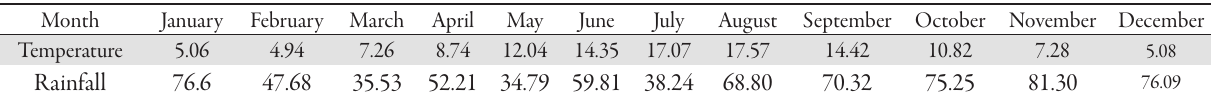
Tab. 2.The meteorological data for wheat-bean intercropping area in